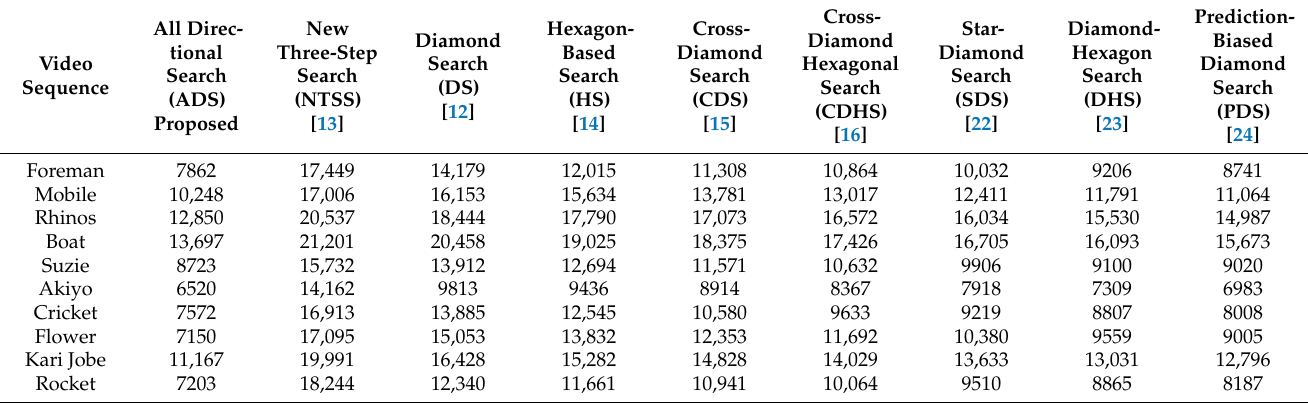
Table 1. The average number of operations per block in each algorithm.